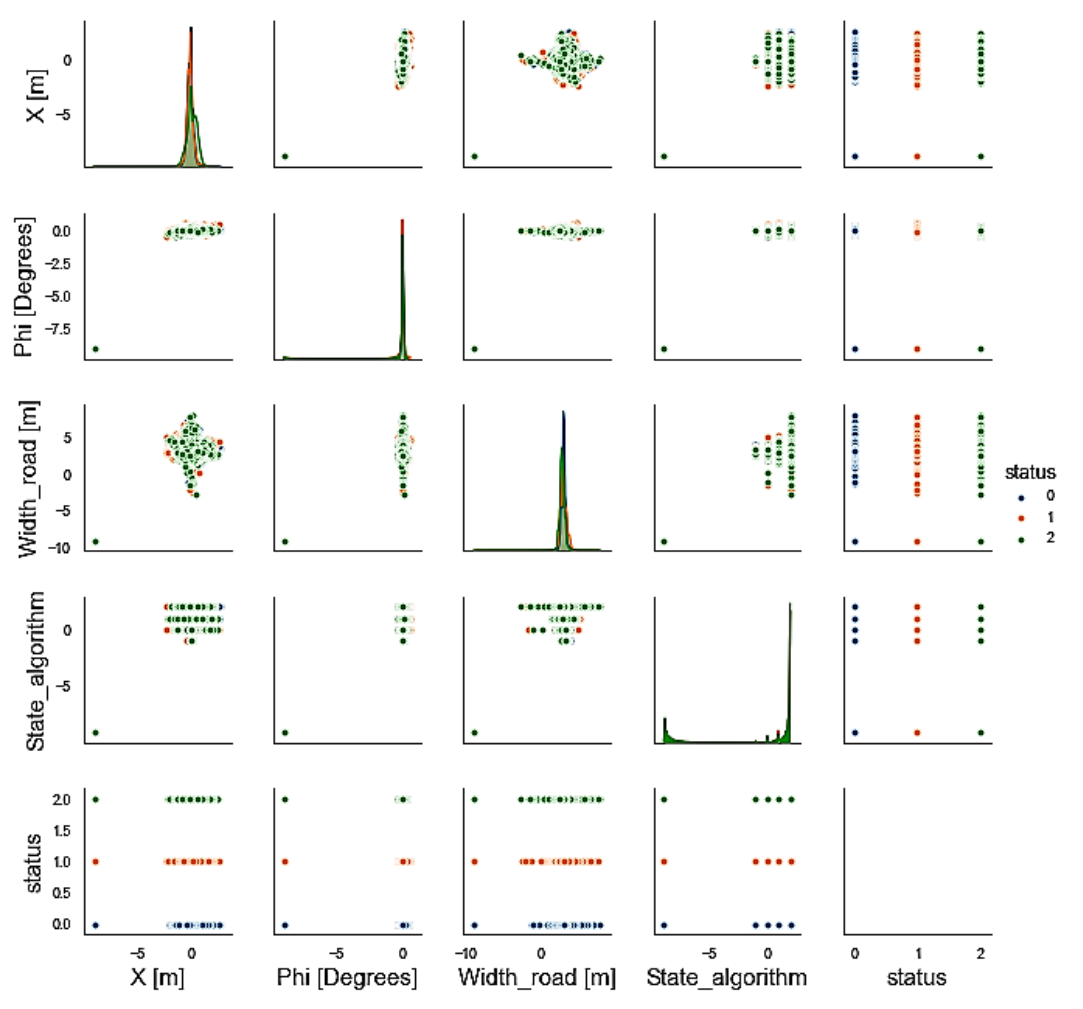
Figure 1. Feature comparison of “lane detection”